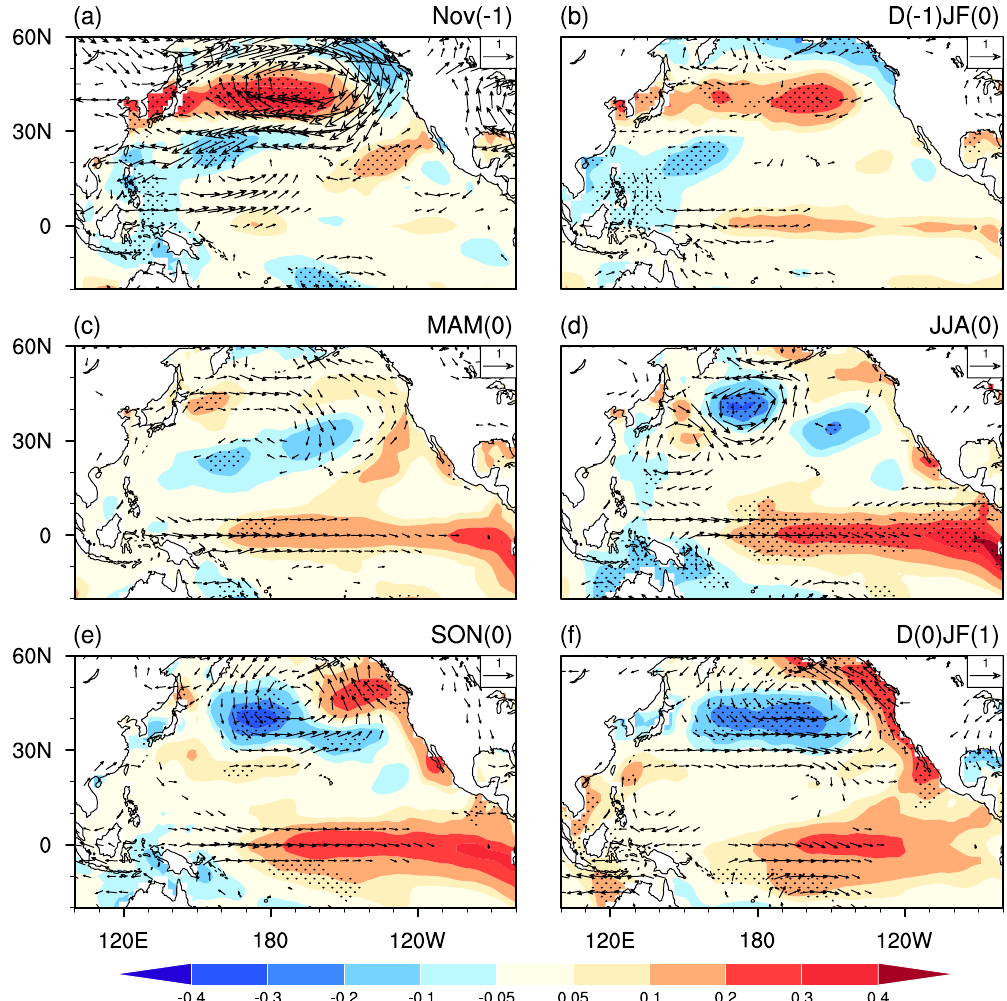
Figure 4. Anomalies of SST (°C, shading) and 850hPa winds (m s − 1 , vector) at ( a ) Nov( − 1), ( b ) D( − 1)JF(0), ( c ) MAM(0), ( d ) JJA(0), ( e ) SON(0), and ( f ) D(0)JF(1) regressed upon the normalized Nov( − 1) AO index. Stippling regions indicate SST anomalies that significantly difference from zero at the 95% confidence level. Wind anomalies in both directions less than 0.2 m s − 1 are not